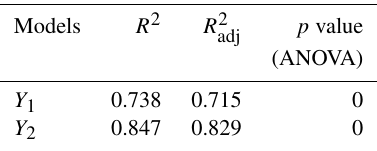
Table 4. The calculated coefficients of regression models 1 and 2. CST indicates the